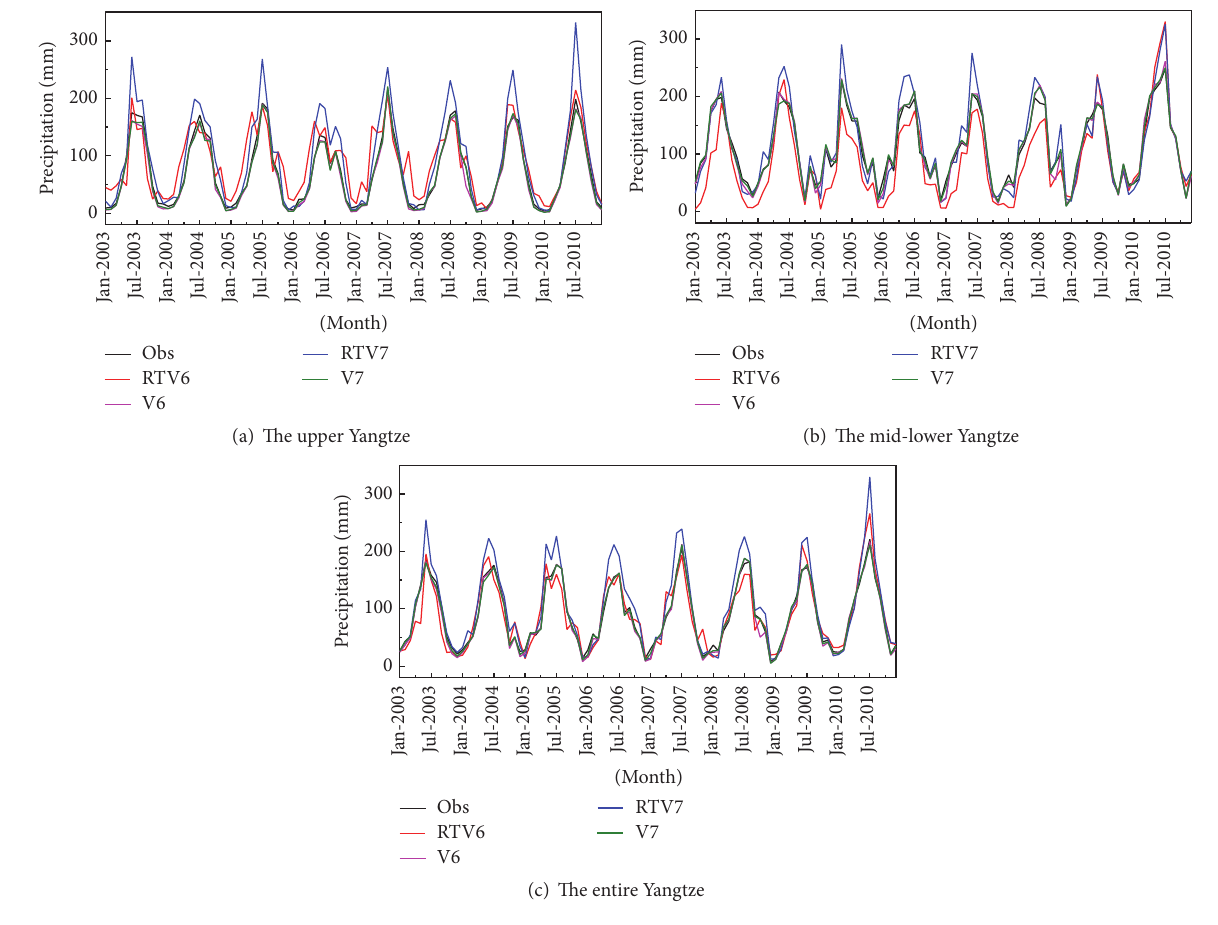
Figure 4: The comparison between the monthly observed and TMPA products precipitation from 2003 to 2010. ((a), the upper Yangtze; (b), the mid-lower Yangtze; (c), the entire